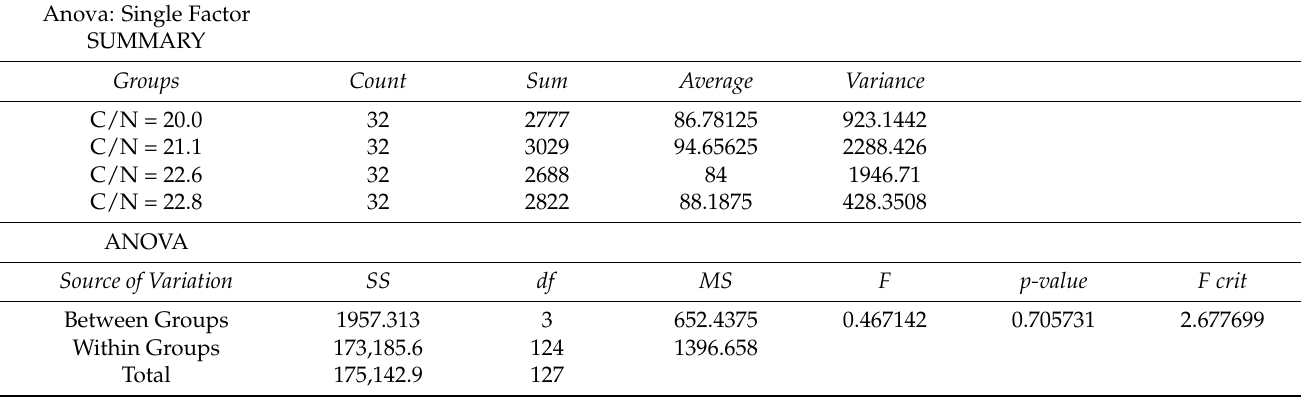
Table A1. One-way (ANOVA) test for daily biogas yield from the first four reactors.